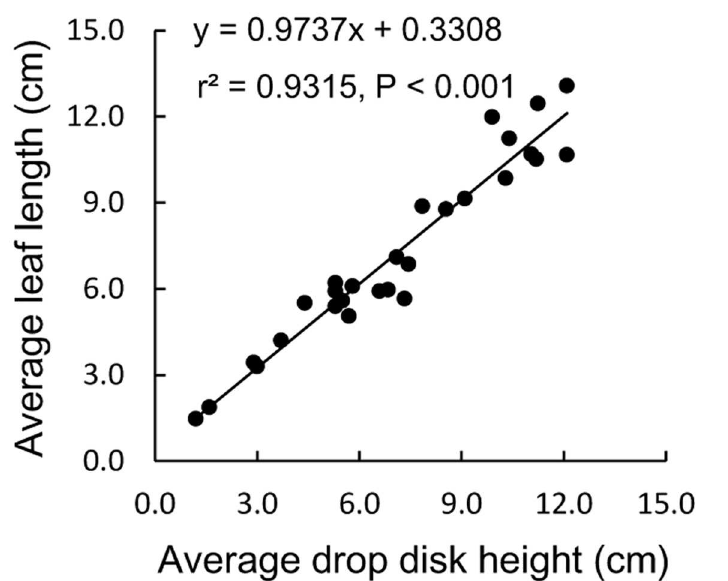
Fig 1. The relationship between drop disk height (cm) and leaf length